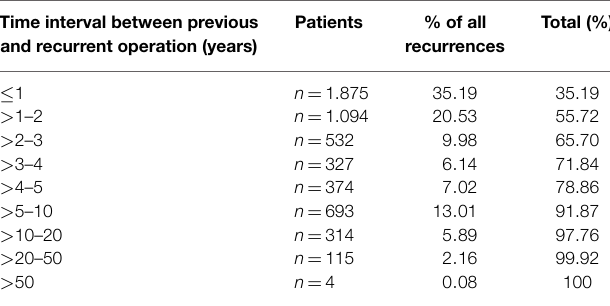
TABLE 2 | Time interval between previous and recurrent incisional hernia repair . Time interval between previous and recurrent operation (years)